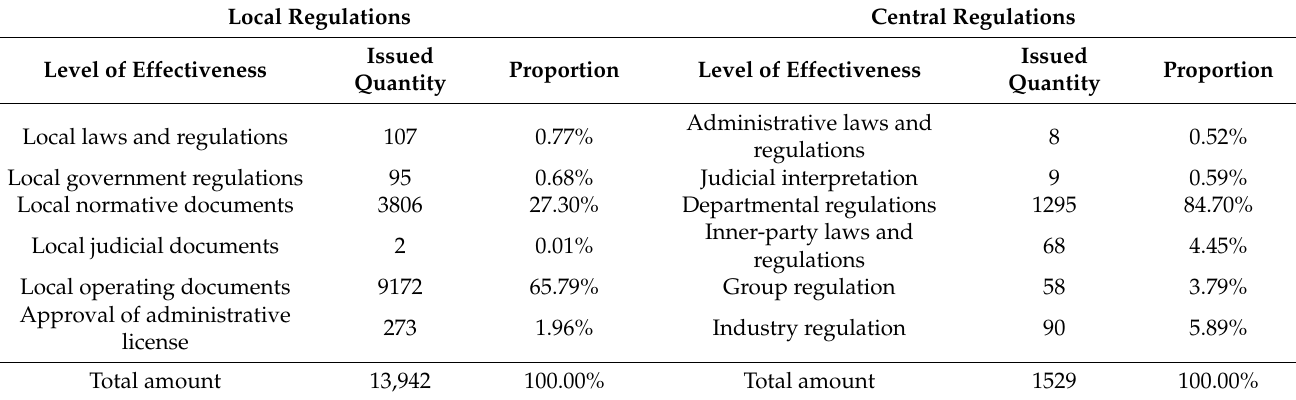
Table 1. Release of China’s talent